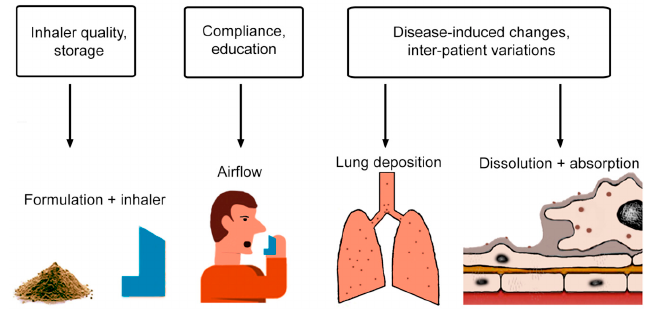
Figure 1. Overview of factors that influence relevant parameters for drug delivery to in the lung.